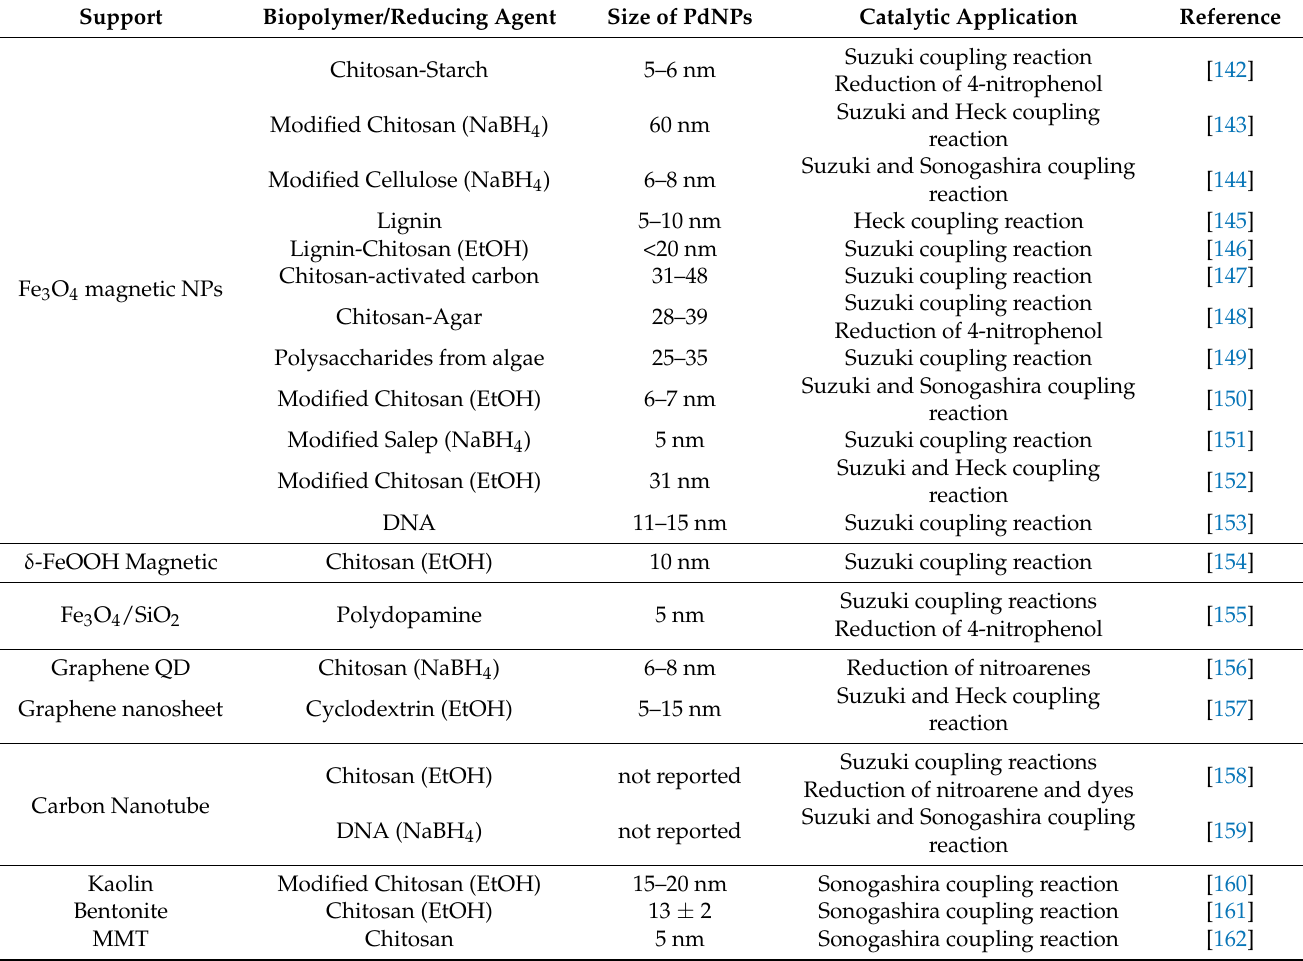
Table 4. Biopolymers as stabilizing and dispersing agent for PdNPs production on the surface of solid supports.